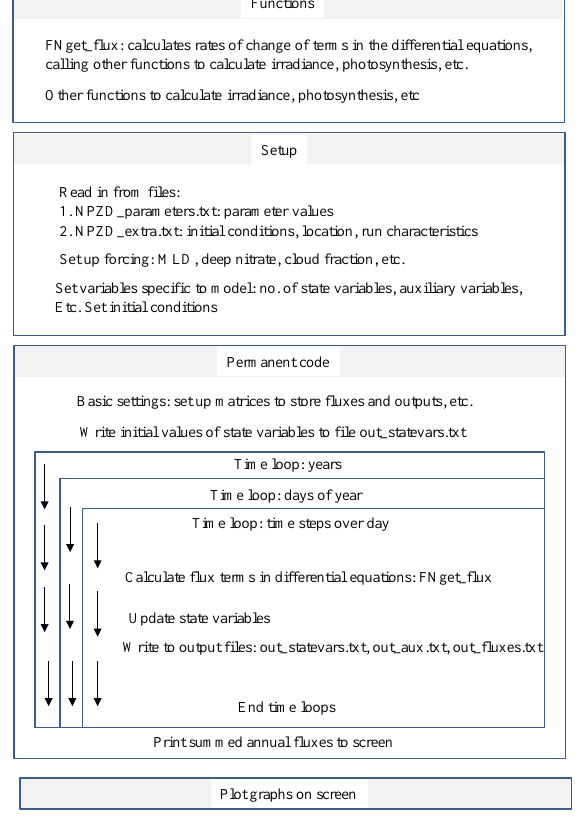
Functions FNget_flux: calculates rates of change of terms in the differential equations, calling other functions to calculate irradiance, photosynthesis, etc. Other functions to calculate irradiance, photosynthesis, etc Setup